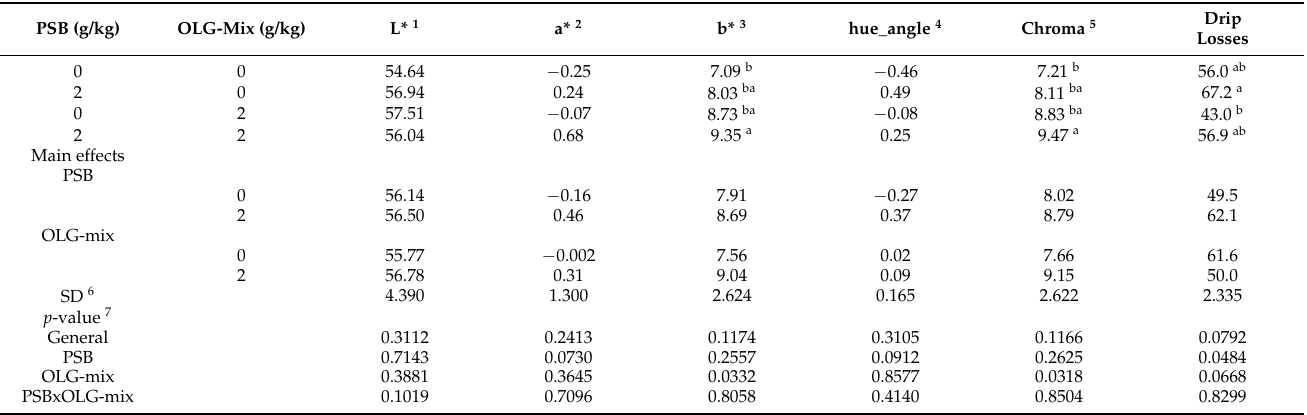
Table 7. Effects of protected sodium butyrate (PSB) and olive leaf and grape-based by-product (OLG-mix), and their interaction on the color of the breast in broilers at slaughter and the drip losses (g/kg) after 24 h of